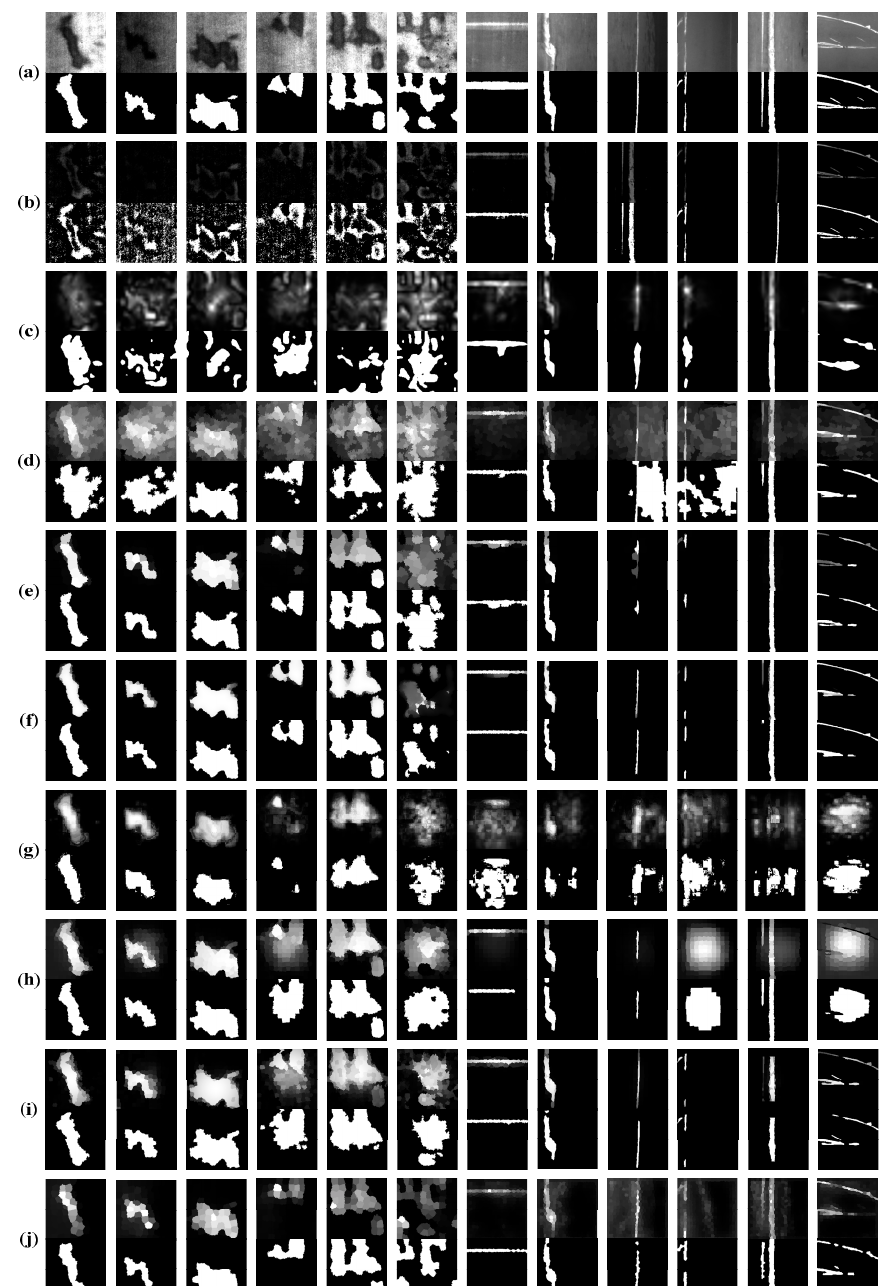
Figure 5. Qualitative comparisons: ( a ) ground-truth; ( b ) RPCA; ( c ) IS; ( d ) ULR; ( e ) RBD; ( f ) SBD; ( g ) DSR; ( h ) RS; ( i ) SMF; ( j ) Ours. We can see that our segmentation results, which are produced by simple Otsu’s method on the saliency map, are very closer to the ground truth.